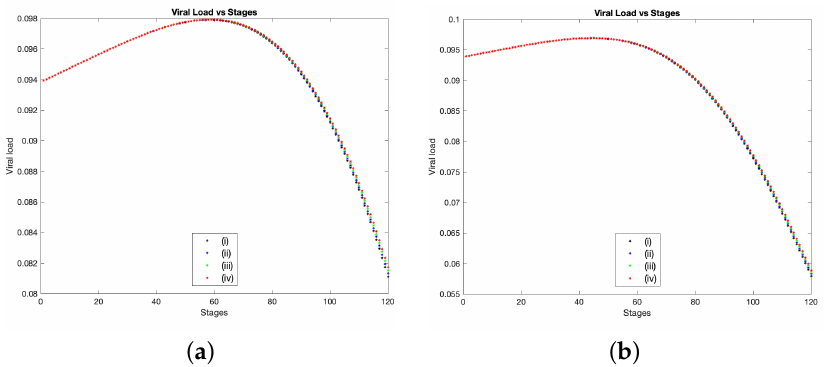
Figure 7. Comparison of viral load of SARS-CoV-2 over time stages from 1 to 120 (which is equivalent to approximately 2.78 h to 14 days) for three different rates of diffusion for all system components (12) using the baseline values presented in Table 1 in the case when ψ with the following percentage variable: ( a ) ζ : = 150%, ( b ) ζ : = 200%. (i) D ∀ k ∈ { h , i , v , c , f , r , β , α }